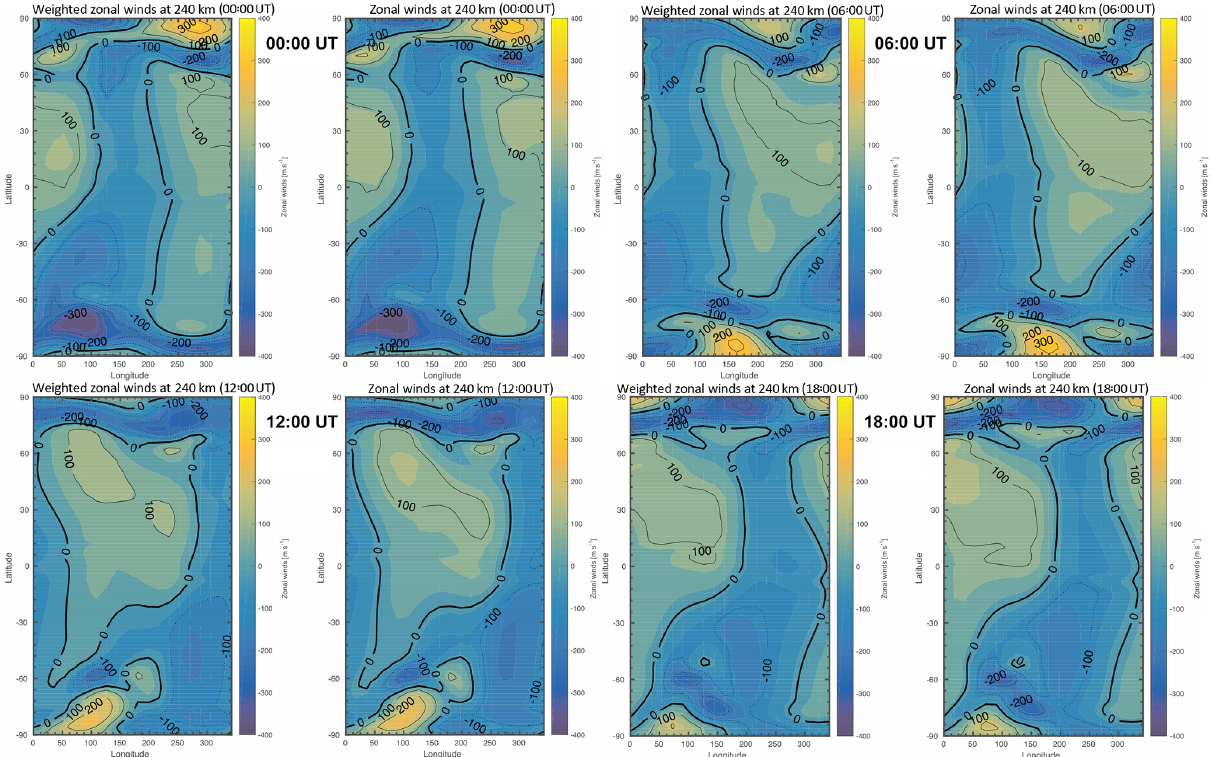
Figure 15. CMAT2 global zonal winds for a quiet day on 1 December 2007 for the winds at 240km and the height-integrated winds weighted using an emission profile from Vlasov et al. (2005) model. The top row shows 00:00UT (the two left panels) and 06:00UT (the two right panels); the bottom shows 12:00UT (the two left panels) and 18:00UT (the two right